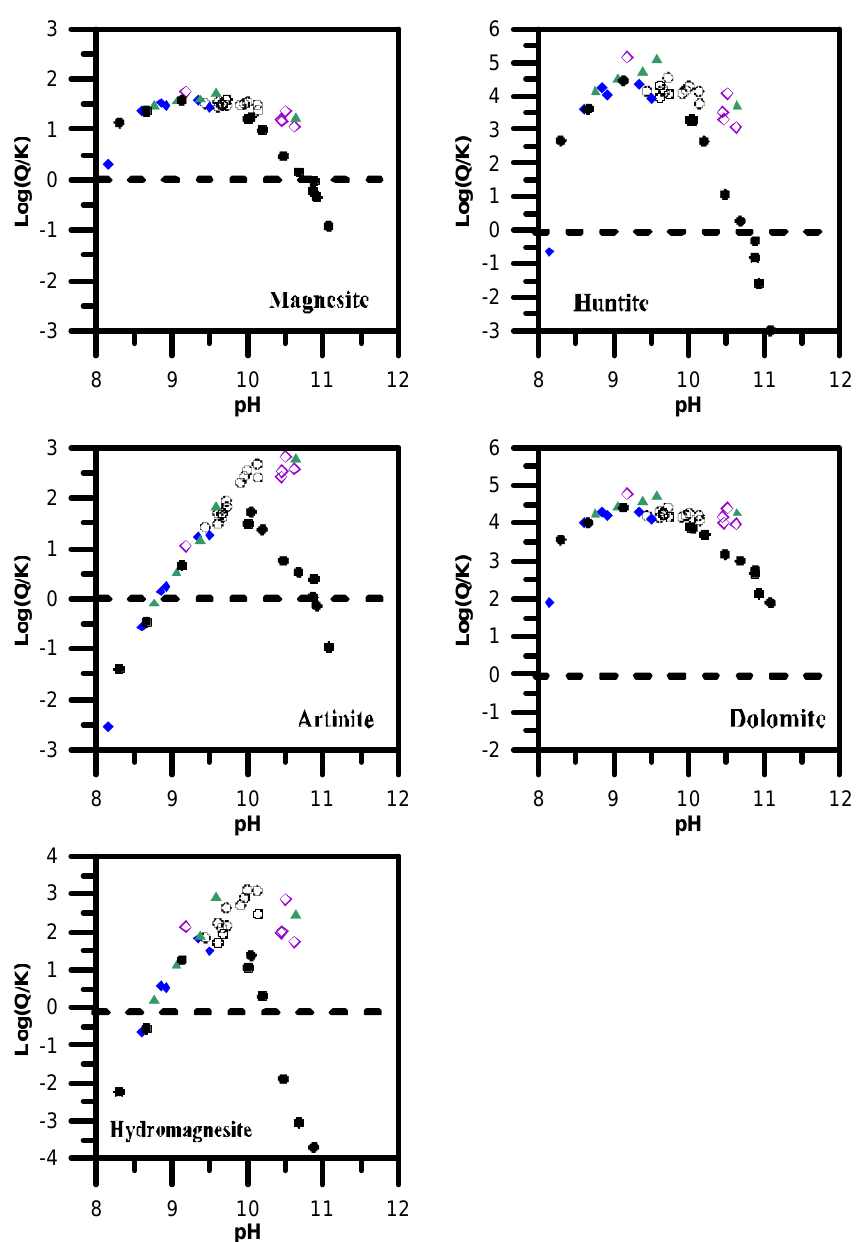
Figure 10. The saturation state of various magnesium/calcium carbonates of the Prony Bay waters versus pH. Same symbols as for Fig. 5. The horizontal dashed line represents the chemical